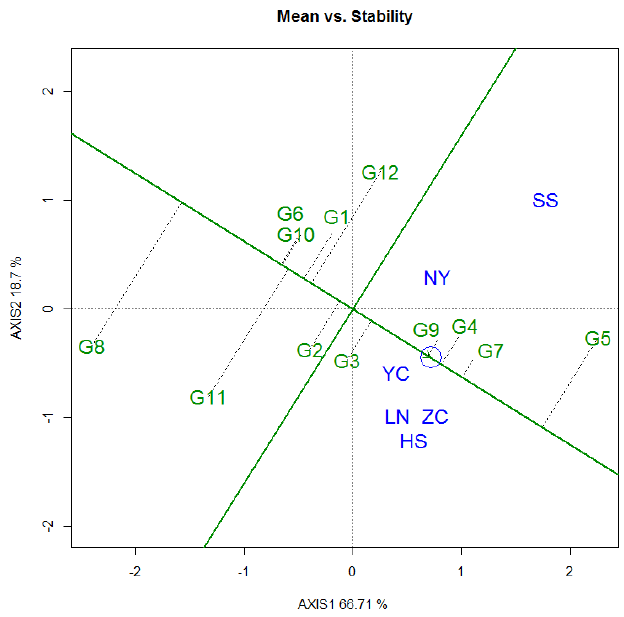
Figure 11. DBH mean and stability of 12 genotypes.